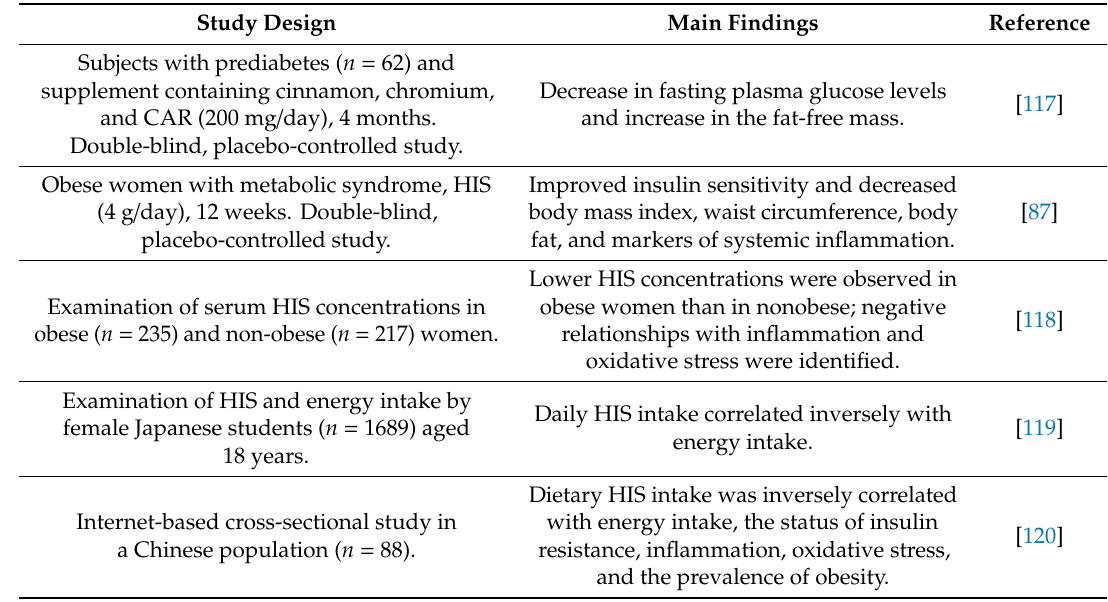
Table 4. The e ff ects of HIS and CAR on humans with obesity and metabolic